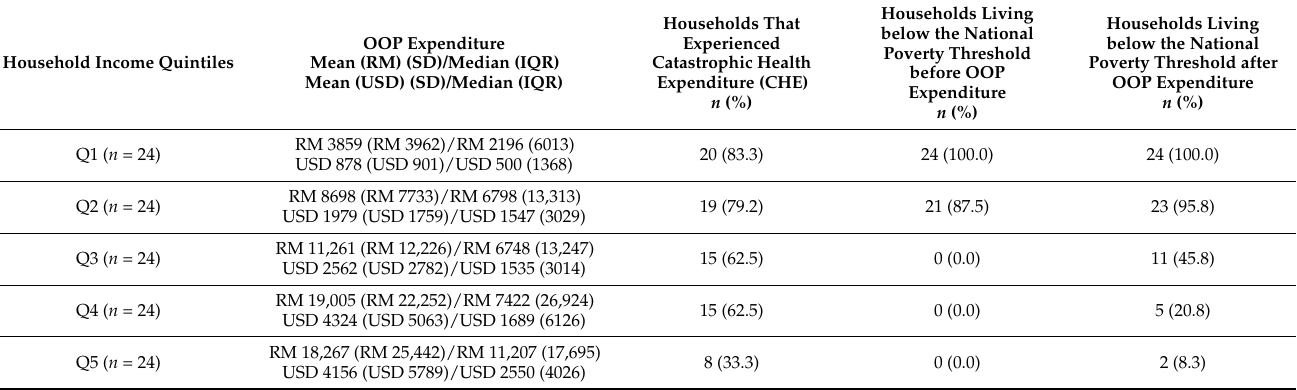
Table 3. Total health-related out-of-pocket expenditure and proportion of households experiencing catastrophic health expenditure and living below the poverty line according to income quintiles ( n =